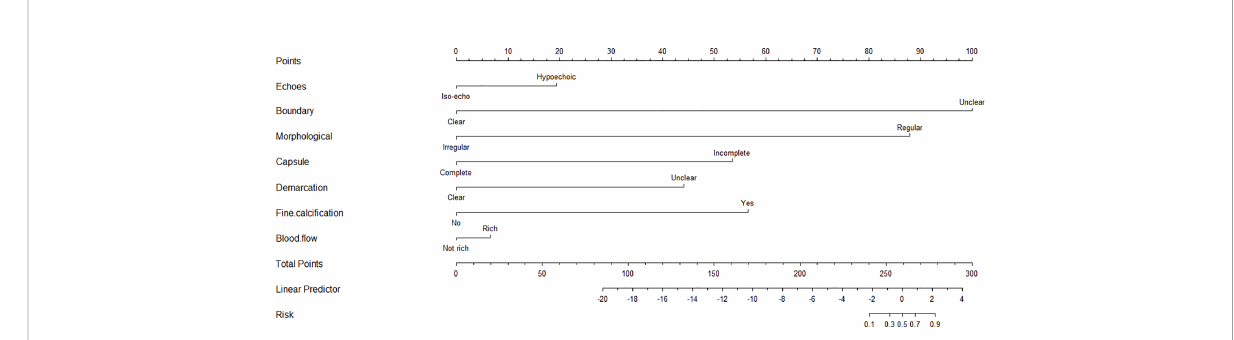
FIGURE 2 The nomogram for predicting the probability of 3D-TRUS in diagnosis of prostate cancer. To calculate the probability, identify the predictor points on the uppermost point scale that correspond to each patient variable and sum them. The total points projected in the bottom scale indicate the probability of 3D-TRUS in diagnosis of prostate